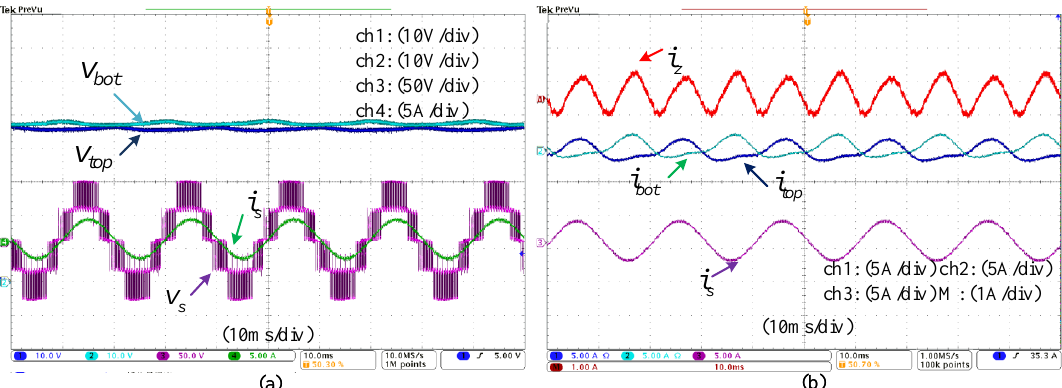
Figure 23. Experiment results with PSC5. ( a ) Phase voltage v s , phase current i s , capacitor voltage of SMs v top and v bot ; ( b ) circulating current i z , phase current i s , arm current i top and i bot